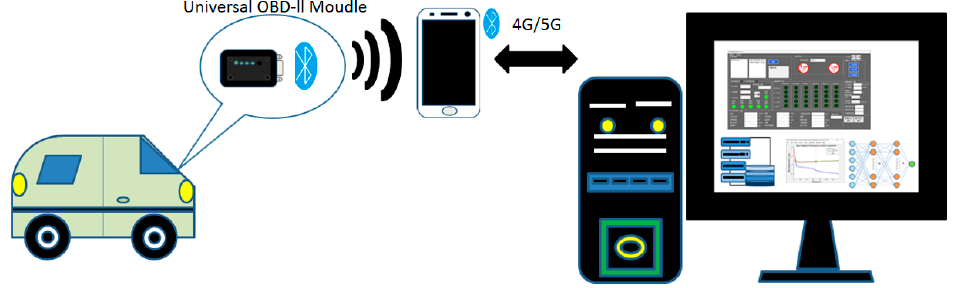
Figure 1. System architecture.